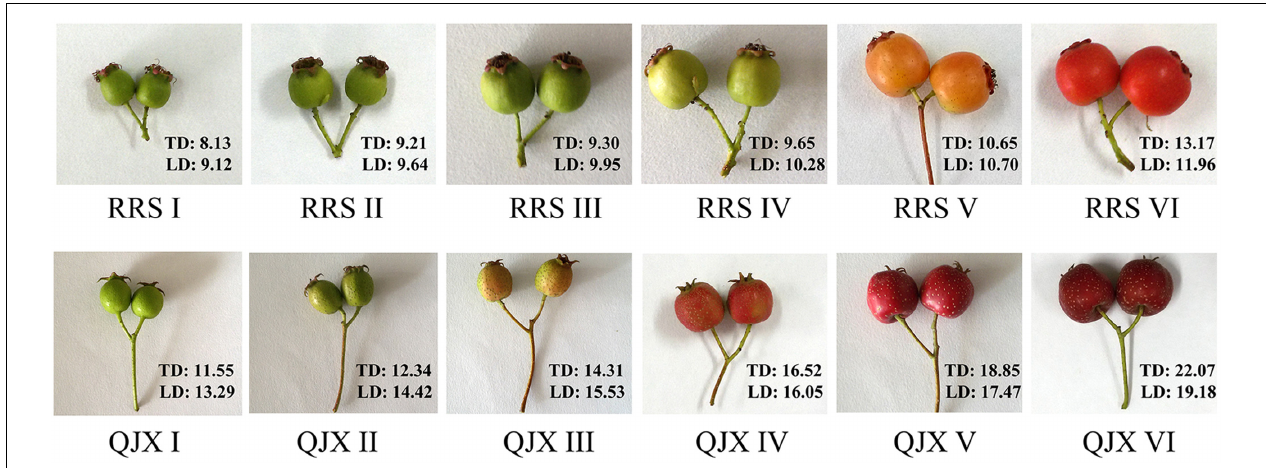
FIGURE 1 | Different stages of ‘Ruanrou Shanlihong 3 Hao’ and ‘Qiu JinXing’ fruit development. TD, transverse diameter (mm); LD, longitudinal diameter (mm).